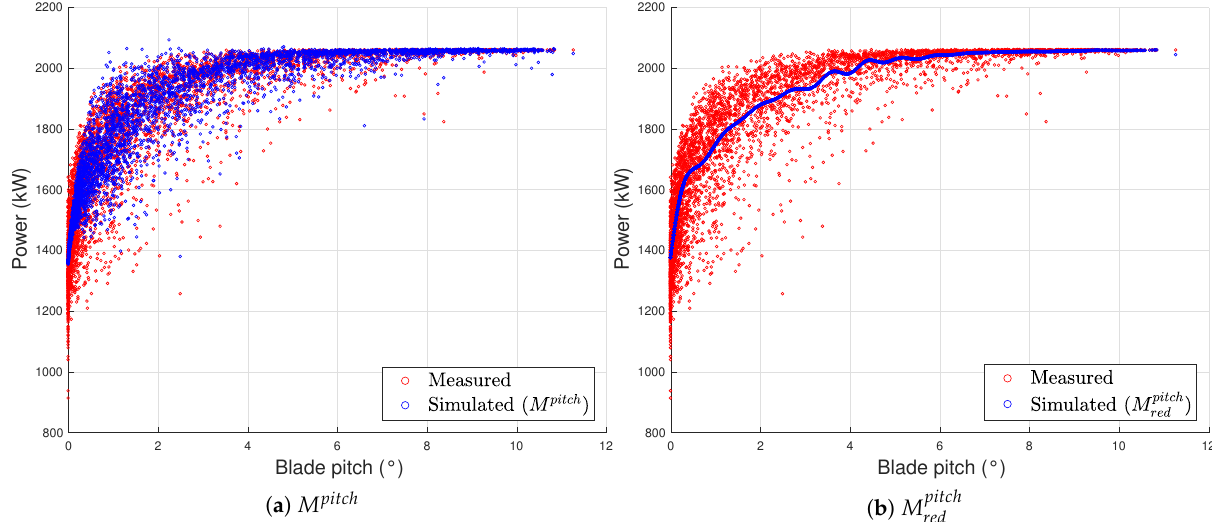
Figure 8. Measured and simulated blade pitch-power curves: D2 data set, T1 wind turbine. M pitch model on the left, M pitch on the